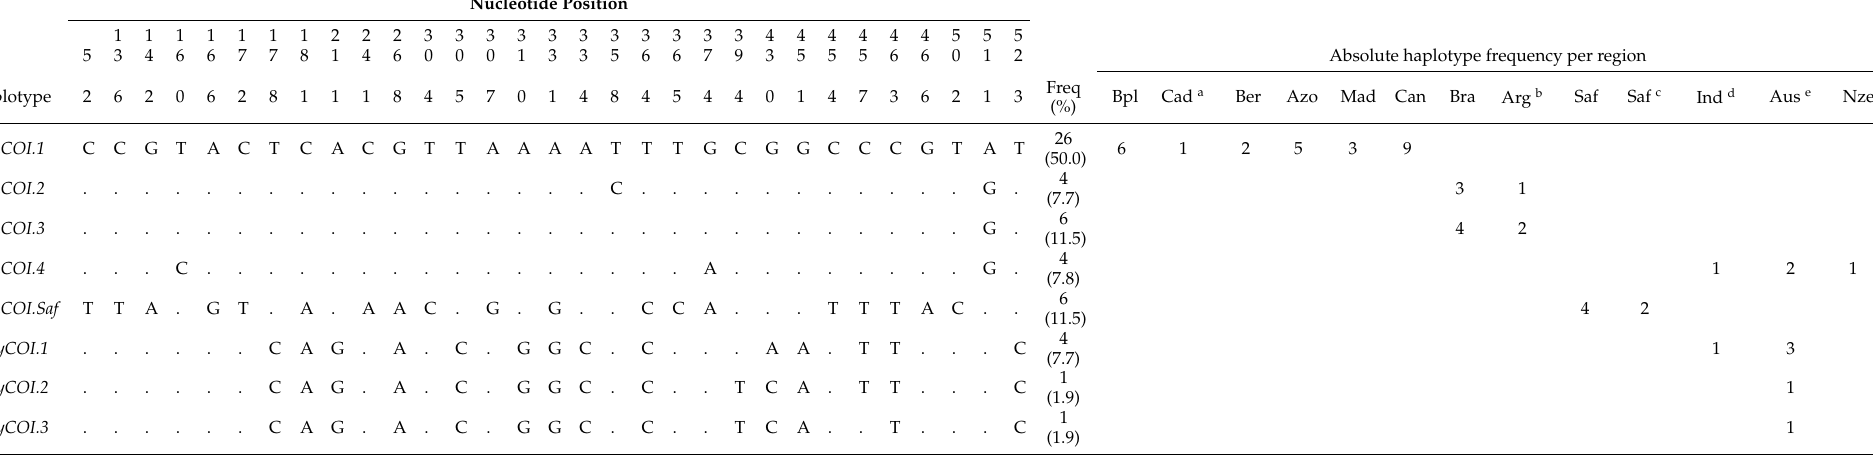
Table 2. Nucleotide polymorphisms, absolute (Freq), and relative (%) frequency of eight COI haplotypes from Polyprion spp. and their distribution per region (see codes in Table 1). Haplotypes PamCOI and PoxyCOI were observed in P. americanus and P. oxygeneios , respectively. Sequence entries from databases cited as footnotes were used in the reconstruction of the ML phylogenetic tree. Current COI haplotypes were used to build the NJ-tree